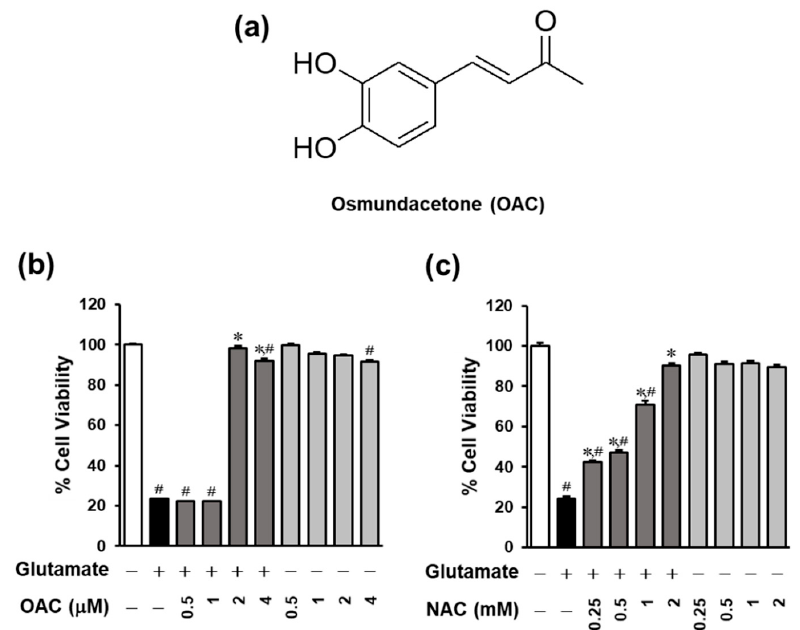
Figure 1. Neuroprotective effect of OAC against glutamate-induced HT22 hippocampal cell death. ( a ) The chemical structure of OAC. ( b ) Cell viability recovered by treatment with OAC in a dose- dependent manner. ( c ) N-acetylcysteine, used as a reference drug, prevented glutamate-induced HT22 cell death. ( d ) Cell morphology changes after 24 h of treatment with OAC at the concentra- tion of 1 and 2 μ M, in the presence or absence of 5 mM glutamate. OAC: osmundacetone; NAC: N- acetylcysteine; ∗ p < 0.001 vs. glutamate-treated group; # p < 0.001 vs. non-treated